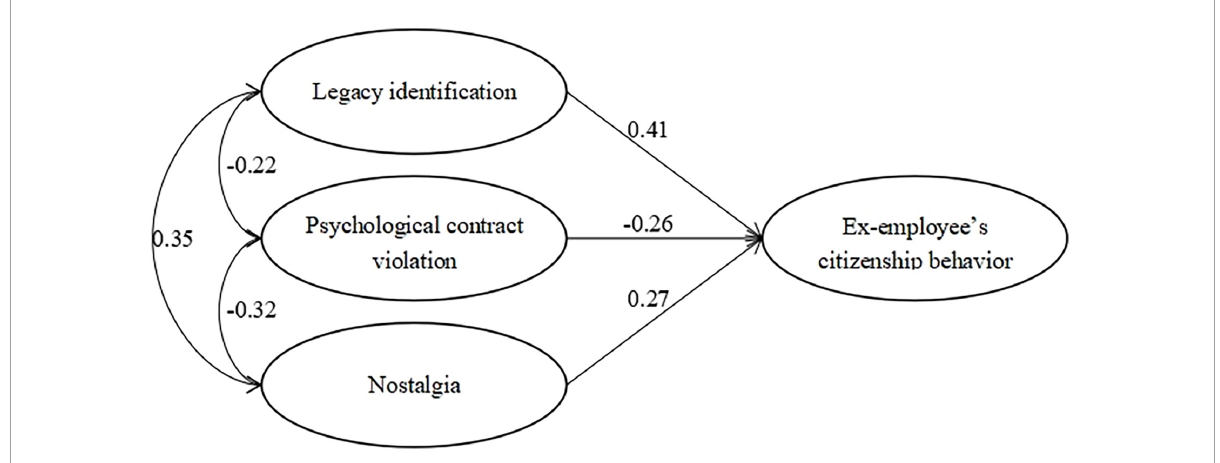
FIGURE3 Results of path analysis for the nomological